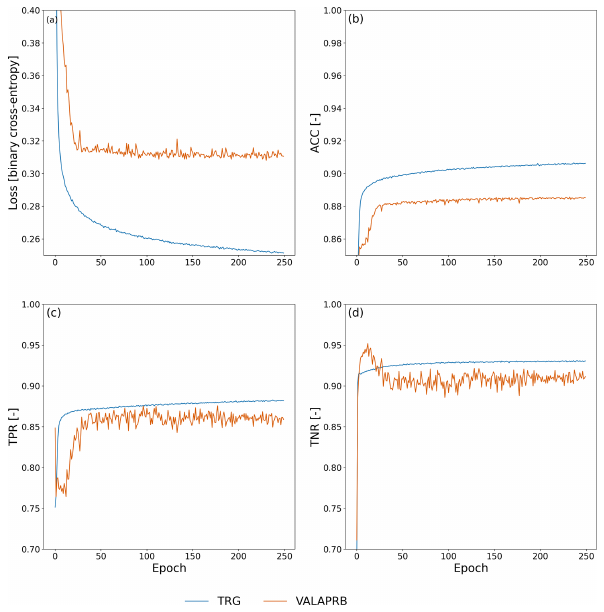
Figure 6. Statistics of variables that were monitored during the training process.